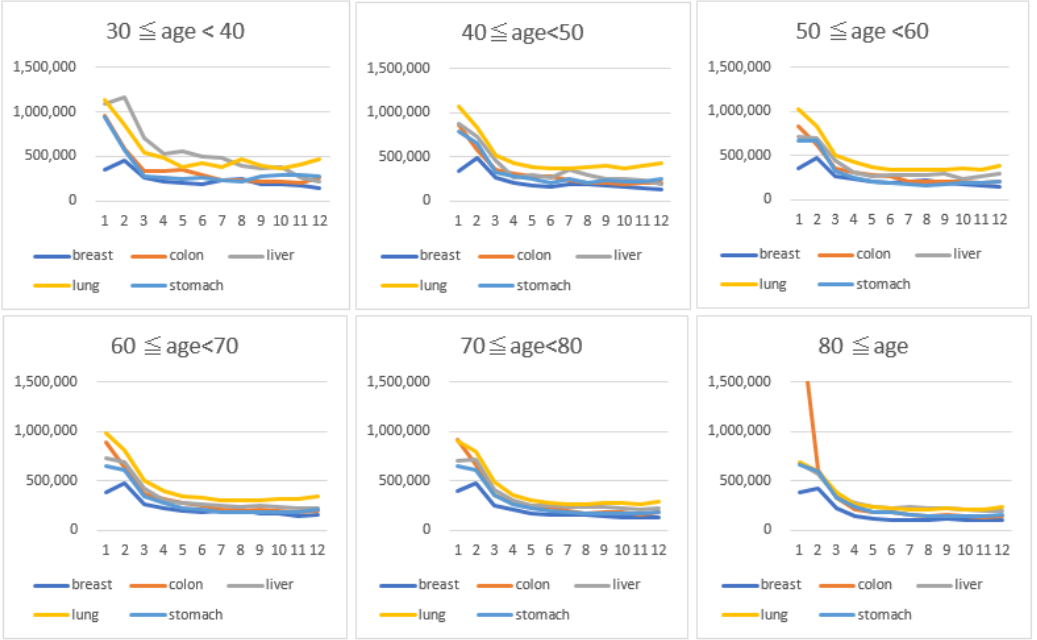
Figure 2. Monthly healthcare cost of each of the five major cancers per-patient stratified by age.